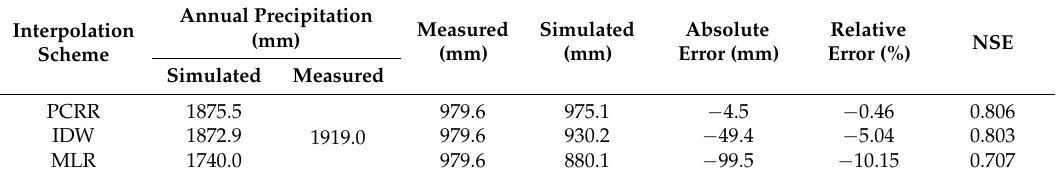
Table 6. Model performance using differently interpolated rainfall